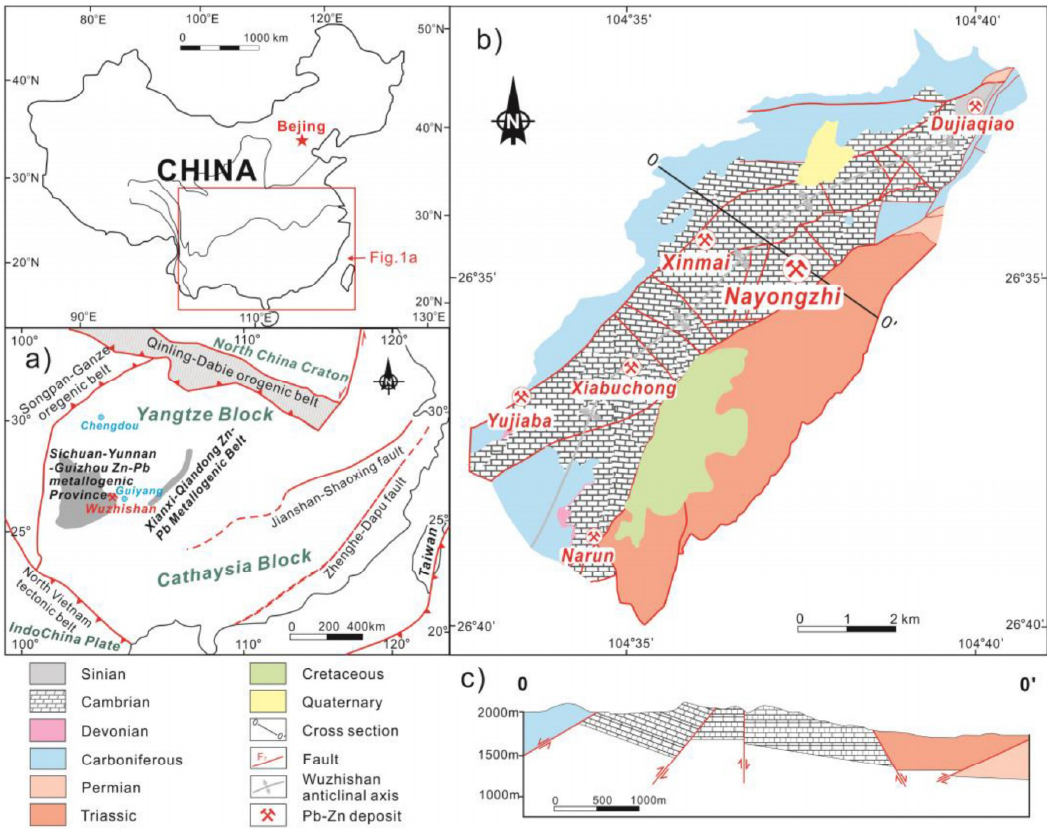
Figure 1. ( a ) Simplified geological map of the South China Craton and adjacent regions showing the framework and the distribution of MVT Zn-Pb deposits in the Yangtze Block (Ye et al. [5] and Hu et al.; ( b ) The geological map of the Wuzhishan anticline showing the location of zinc-lead deposits; ( c ) Geologic cross section 0-0′ showing the Wuzhishan anticline.